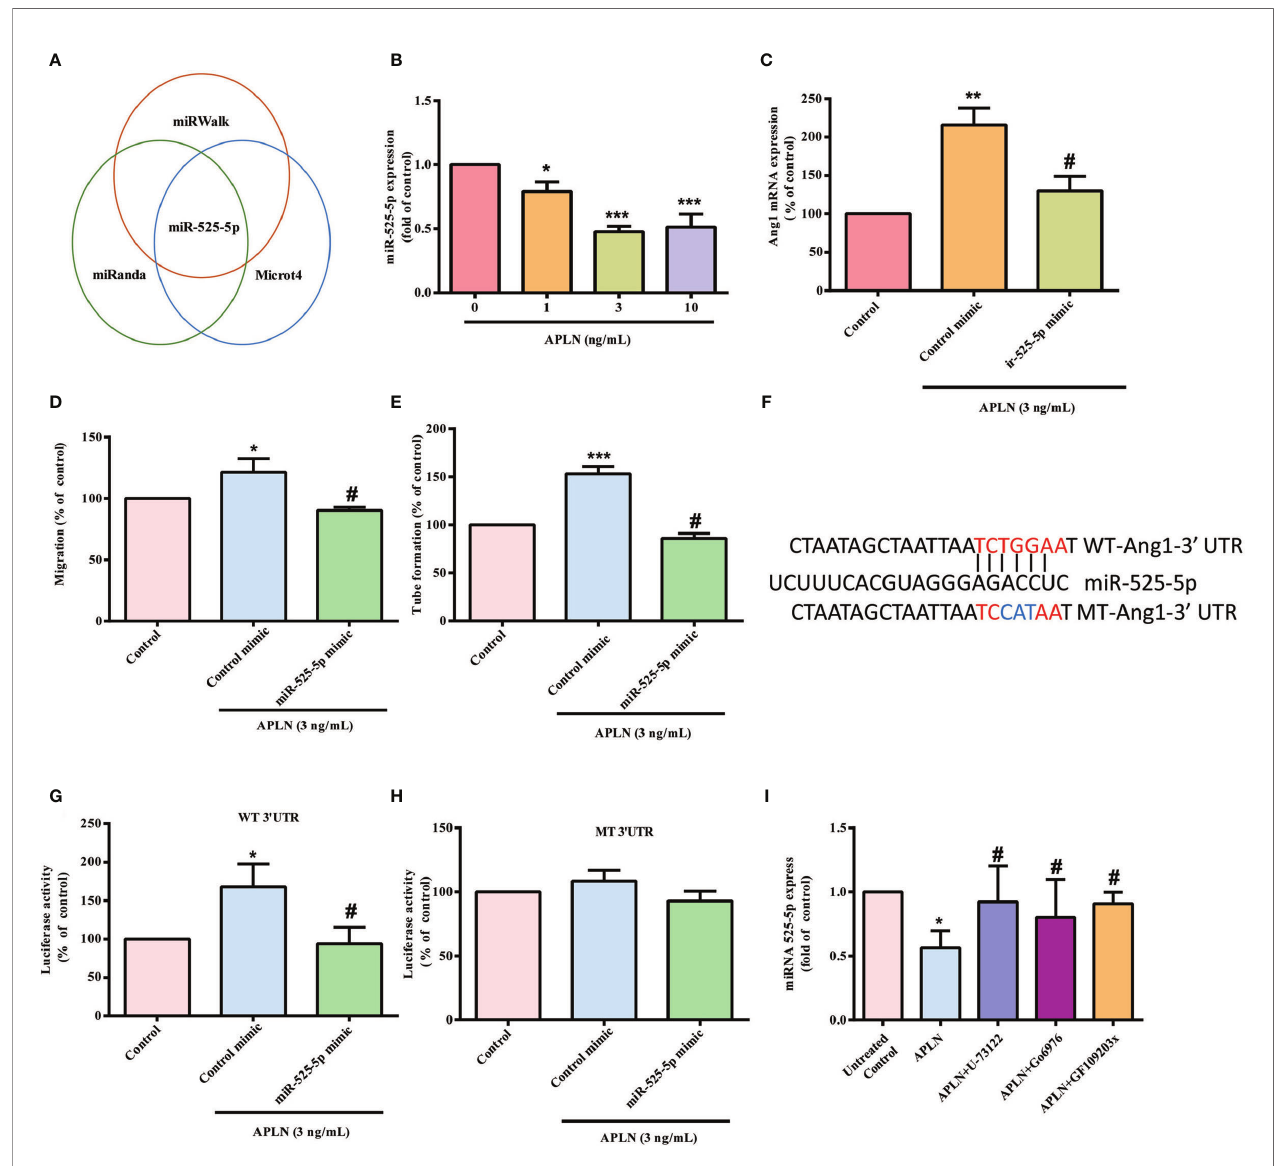
FIGURE 4 | APLN facilitates Ang1 synthesis and EPC angiogenesis by inhibiting miR-525-5p. (A) Open-source software enabled identi fi cation of miRNAs that possibly interfere with Ang1 transcription. (B) RASFs were incubated with APLN for 24 h. miR-525-5p expression was determined by the qPCR assay. (C) RASFs were transfected with miR-525-5p mimic for 24 h, then stimulated with APLN for 24 h. Ang1 levels were determined by qPCR. (D, E) Collected CM was applied to EPCs, and EPC angiogenesis was quanti fi ed. (F) Schematic 3 ′ UTR representation of human Ang1 containing the miR-525-5p binding site. (G, H) RASFs were transfected with the indicated luciferase plasmid with or without miR-525-5p mimic for 24 h, then stimulated with APLN for 24 h. Relative luciferase activity was determined. (I) RASFs were pretreated with U73122, GF109203X and Go6976 for 30 min, then stimulated with APLN for 24 h. miR-525-5p expression was quanti fi ed by qPCR. * p < 0.05, ** p < 0.01 and *** p < 0.001 versus the control group; # p < 0.05 versus the APLN-treated